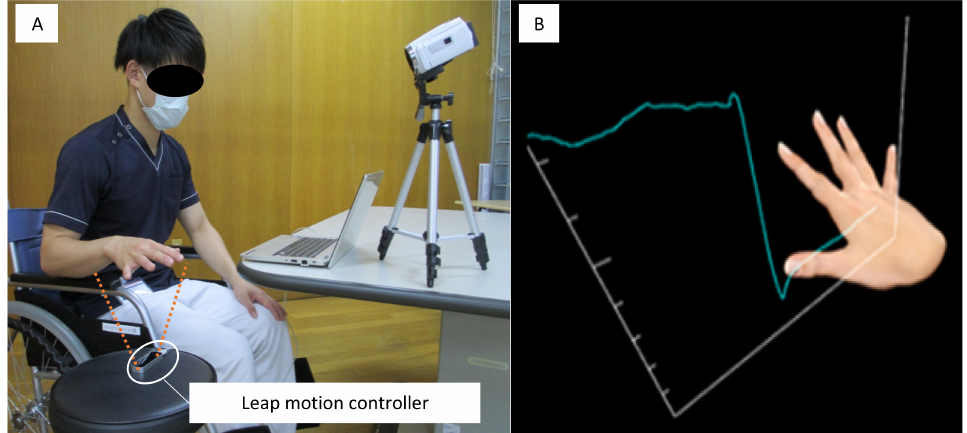
Figure 2. The Fahrenheit System. ( A ) The position of the patient during measurement. ( B ) Virtual hand movements displayed in real time. The vertical axis represents the numeric value of finger movements, and the horizontal axis represents the measurement